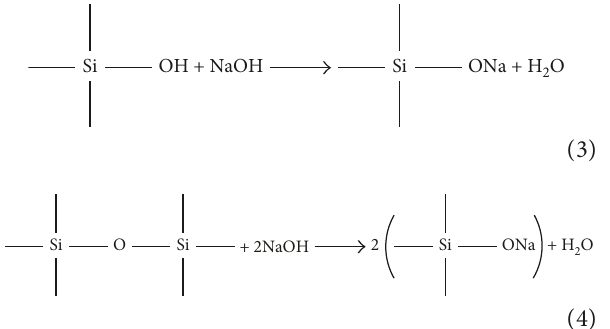
Figure 9 is a hydration mechanism diagram of fly